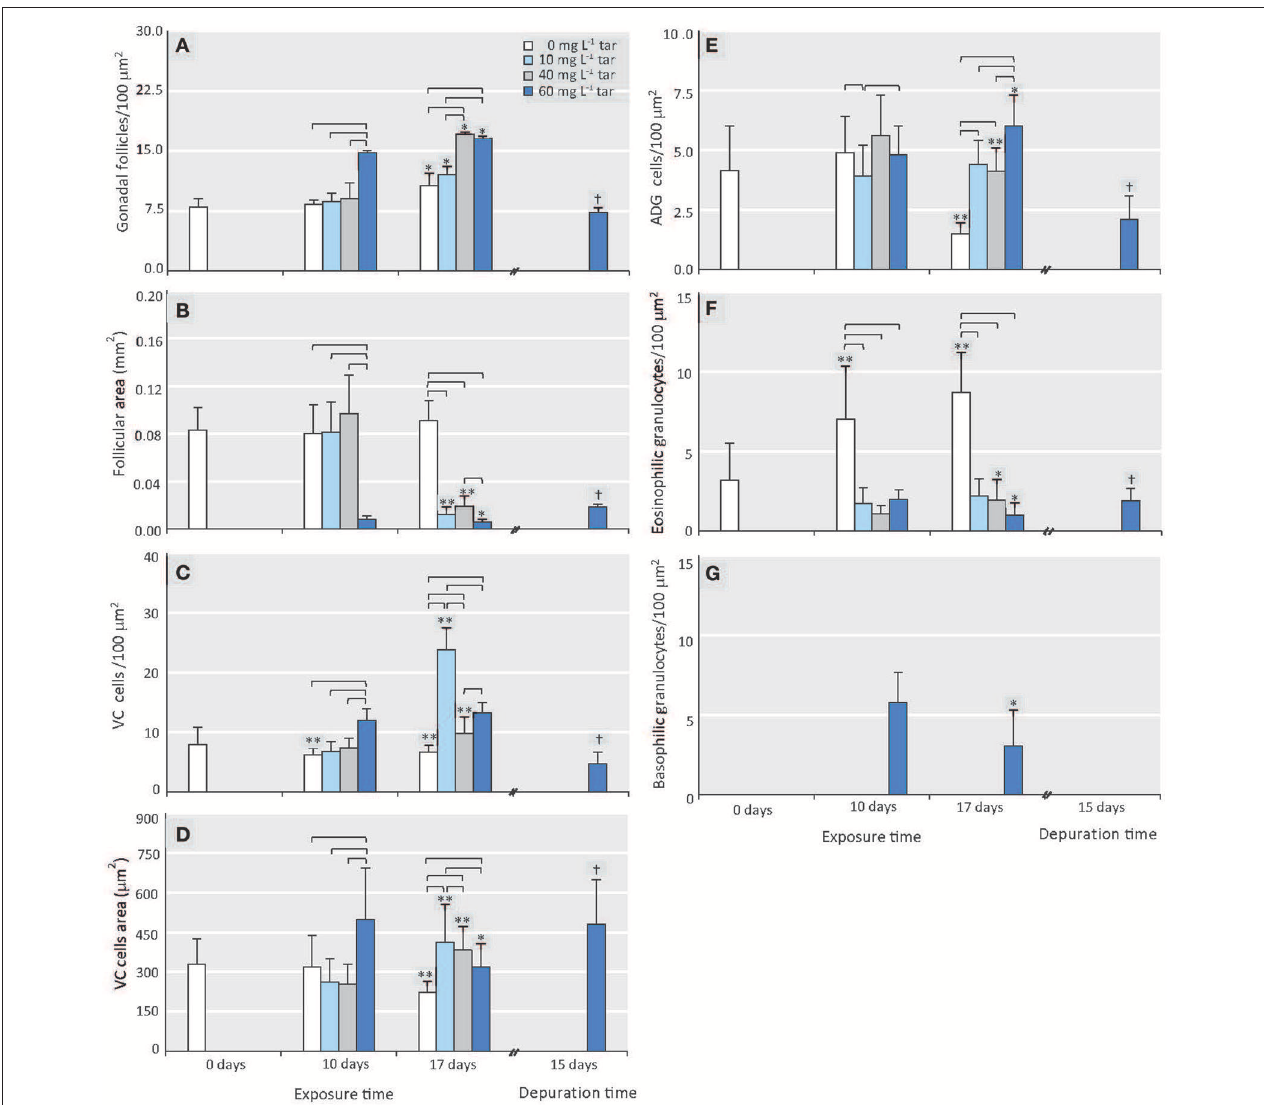
FIGURE 3 | Effect of different tar concentrations and exposure times on histological morphometric parameters. (A) Number of gonadal follicles. (B) Area of gonadal follicles. (C) Number of VC cells. (D) Area of VC cells. (E) Number of ADG cells. (F) Number of eosinophilic granulocytes. (G) Number of basophilic granulocytes. Data are represented as means ± SD, n ≥ 8. Reference mussels (0mg L − 1 tar). Square brackets represent significance differences between mussels exposed to different tar concentrations during same time ( p < 0.001). Significance differences between mussels exposed to each of the tar concentrations at different times: * p < 0.01, **